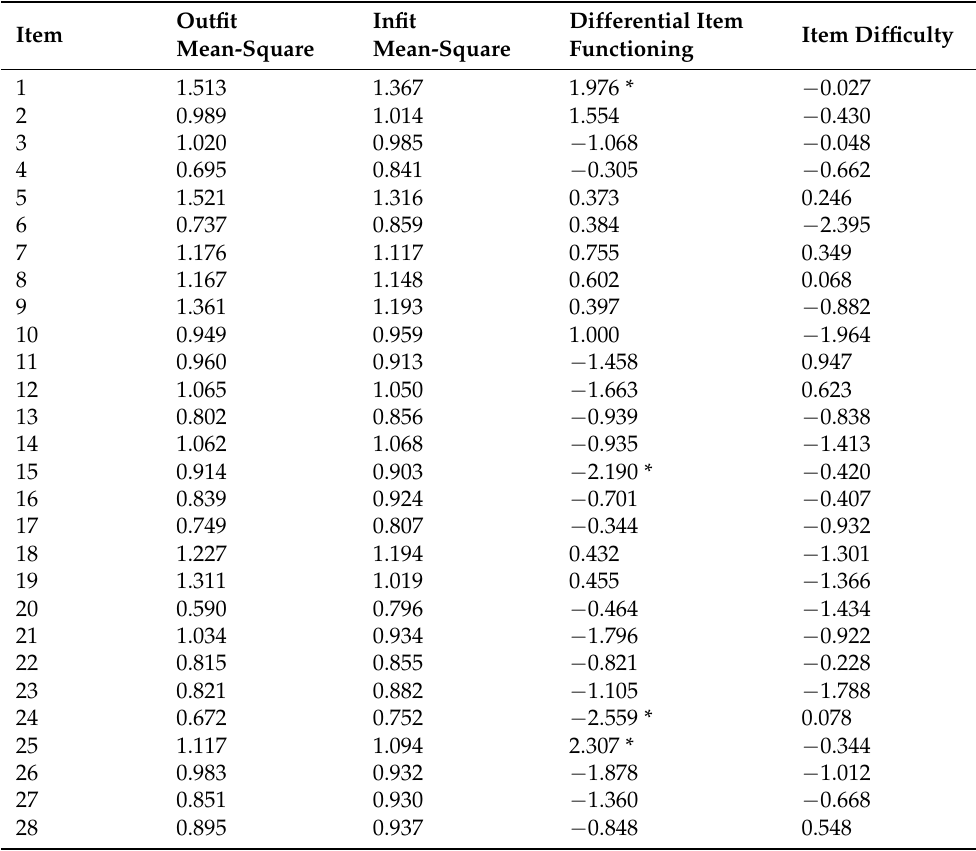
Table A1. Outfit, infit, differential item functioning, and item difficulties for all